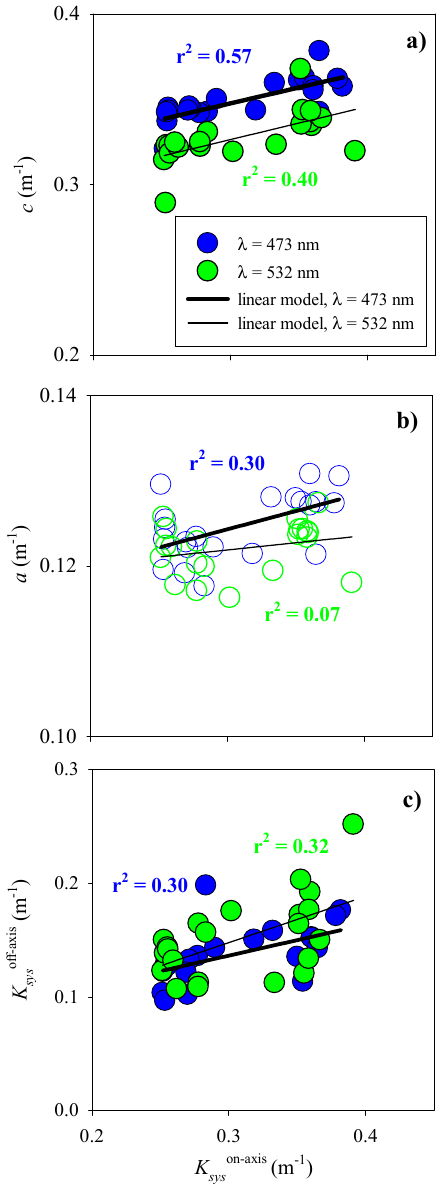
Figure 6. Relationships between K sys and IOPs. ( a ) c vs K sys (on-axis), ( b ) a vs K sys (on-axis), and ( c ) K sys (off-axis) vs K sys (on-axis). Regression functions (solid lines). For on-axis measurements, the structural dissimilarity was highly variable between captures obtained in relatively deep waters ( <SDI> = 0.08 ± 0.005, λ = 473 nm, and 0.08 ± 0.006, λ = 532 nm, 9:36–10:03 am) and shallow ( <SDI> 0.09 ± 0.005, λ = 473 nm, and 0.08 ±